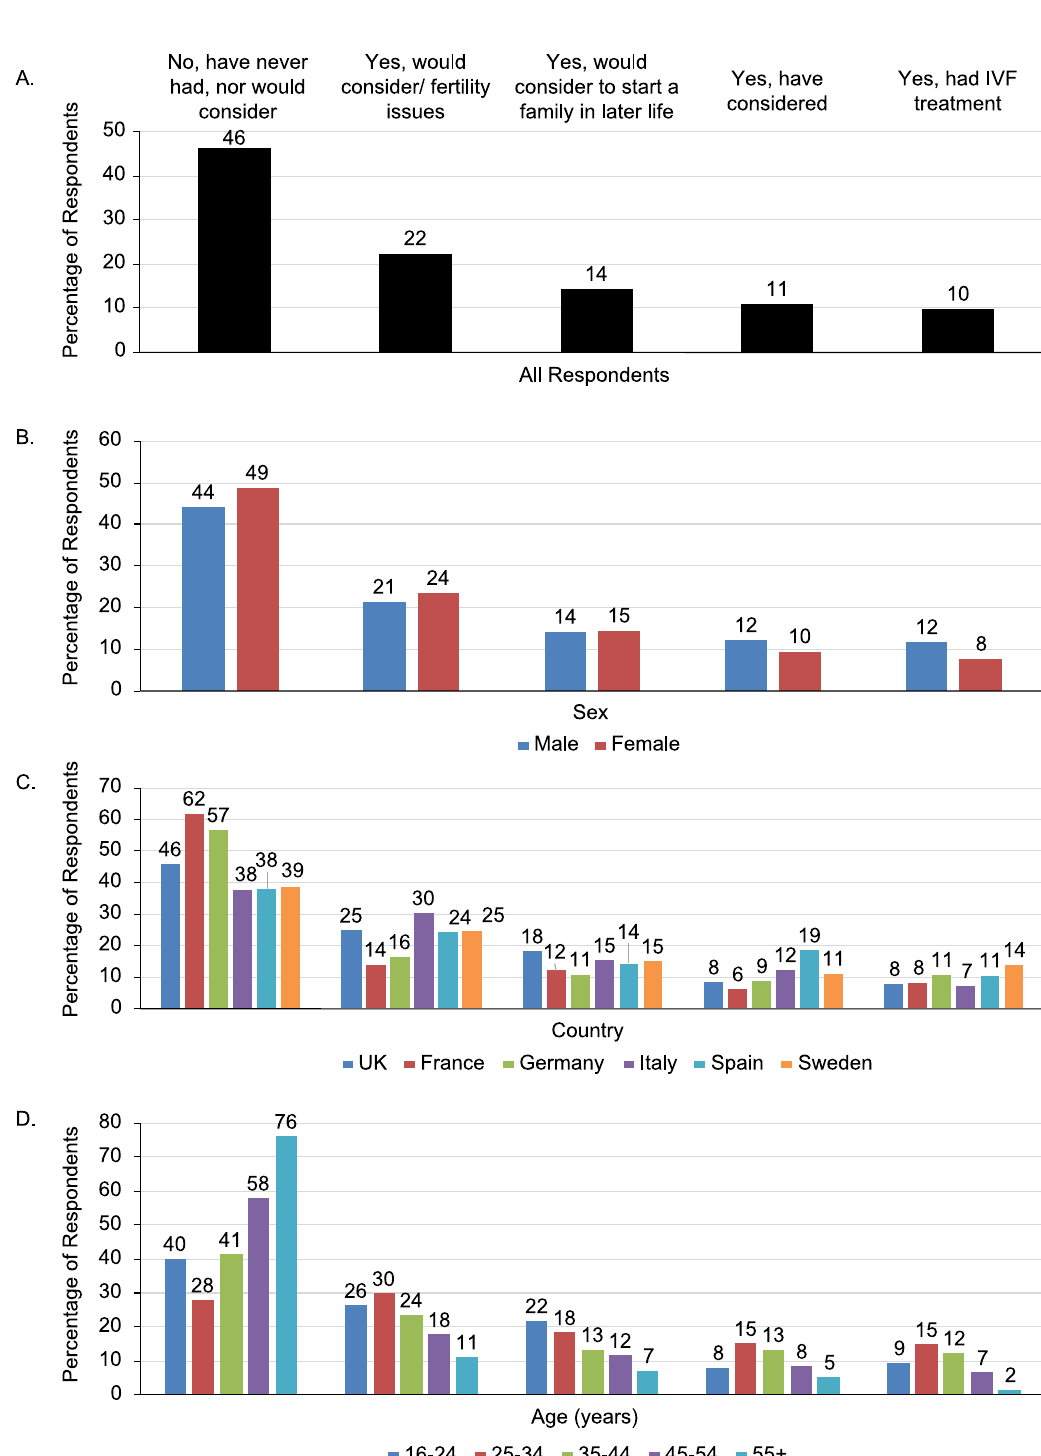
Fig 1. Degree of acceptance of IVF (A) among all respondents; (B) by sex; (C) by country; (D) by age. Respondents could select more than 1 response. Please refer to the questionnaire for full response text.